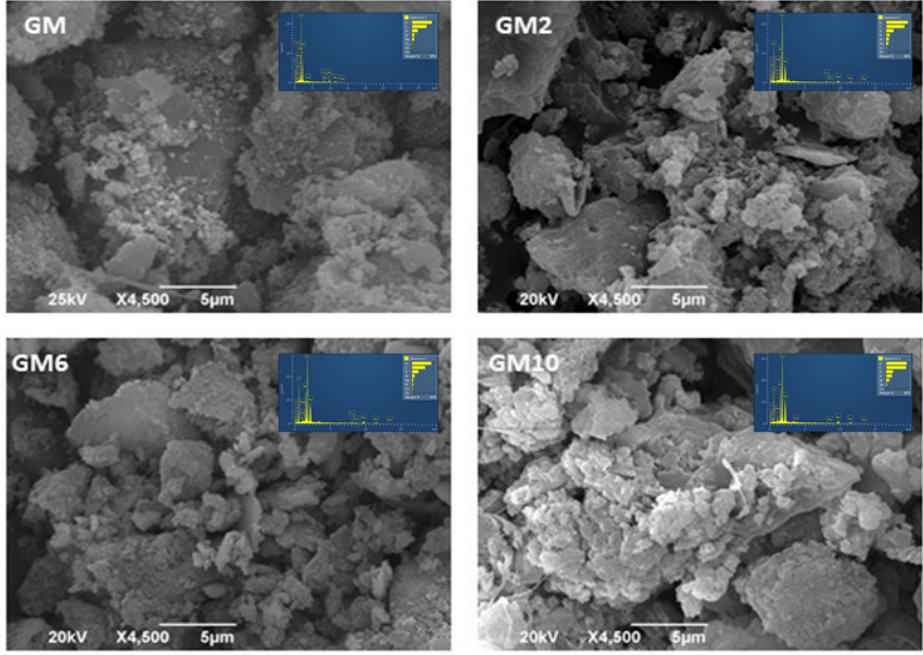
Figure 7. SEM-EDS microphotographs of GM, GM2, GM6, and GM10.